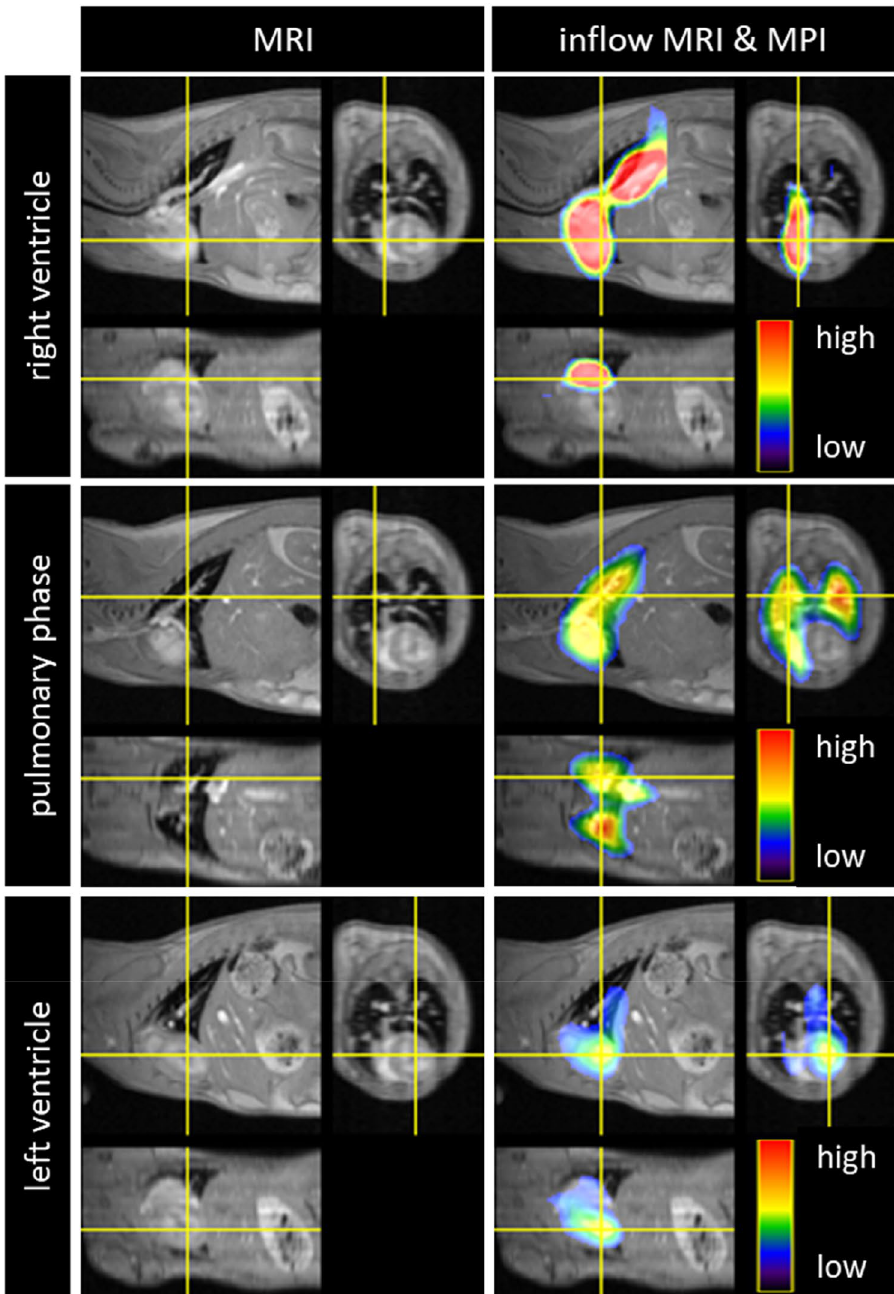
Figure 2. MRI and fused MPI-MRI-data at three distinct time points showing the inflow of tracer into the right ventricle, the passage through the lungs and the arrival at the left ventricle. The MPI signal intensities are color coded. A high amount of tracer per pixel is indicated in red while a low amount in